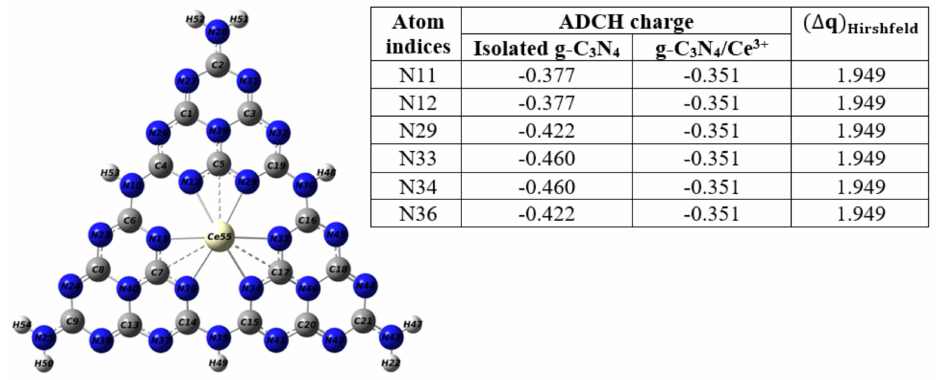
Figure 22. The ADCH charges and charge differences of the nearest carbon and nitrogen atoms adjacent to the central Ce 3+ ion within Ce-GCN. Reproduced with permission from Ref. [138]. Li et al. reported on Er-GCN with different doping dosages. It was found